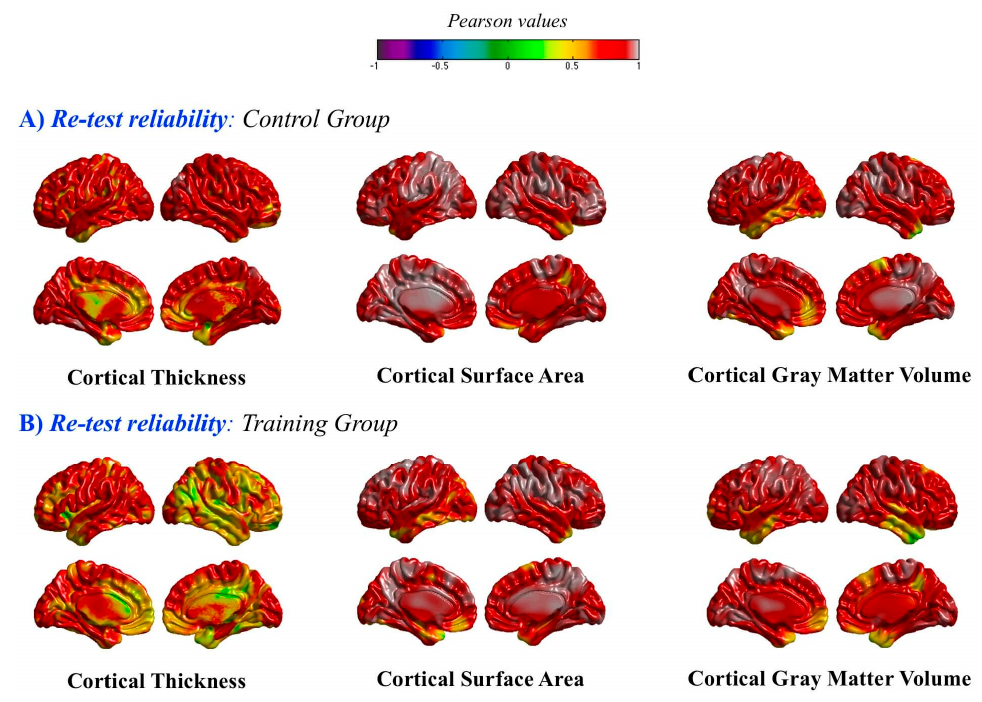
Figure 5. Pre-post Pearson correlations at the vertex level ( A ) in the control group and ( B ) in the training group, for the three surface-based morphometry (SBM) indices: thickness, surface area, and volume.